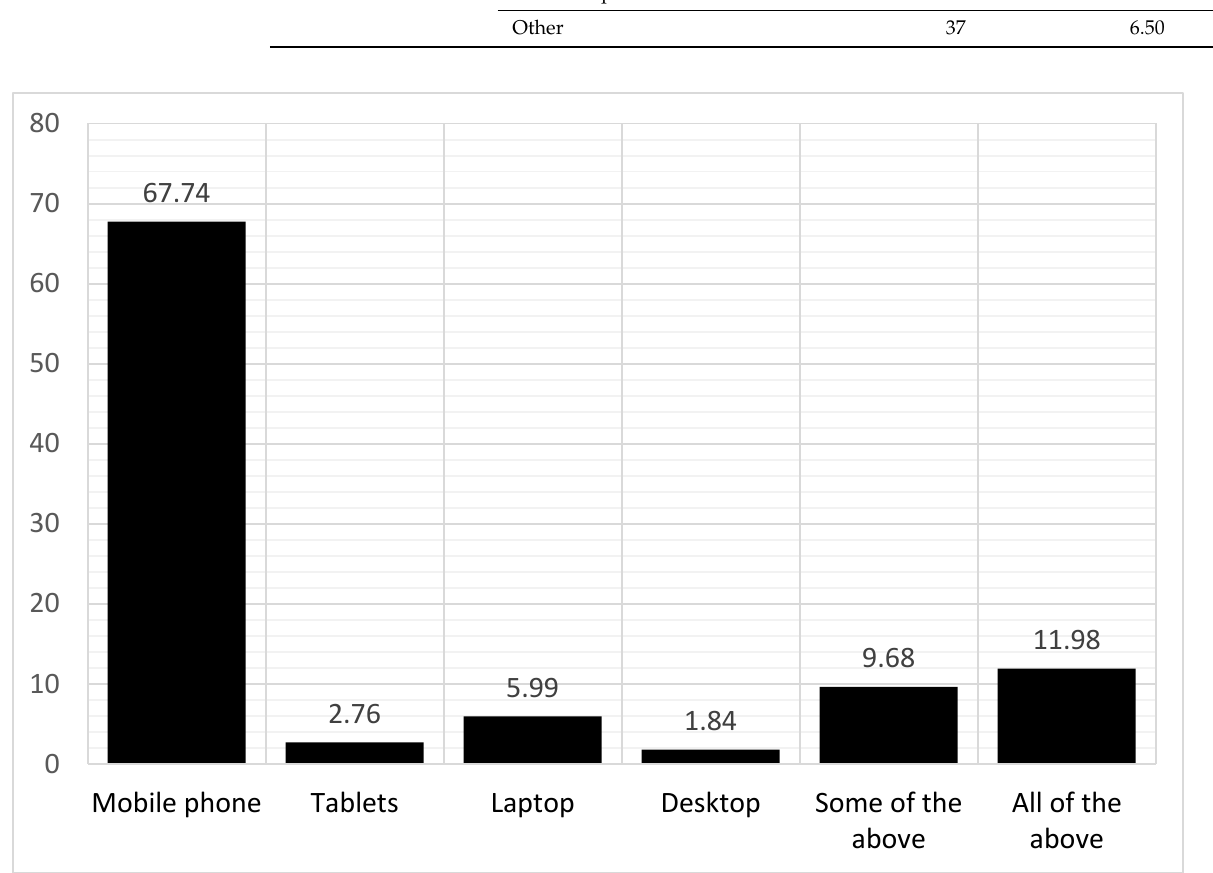
Figure 2. Tools that were used for telemedicine.